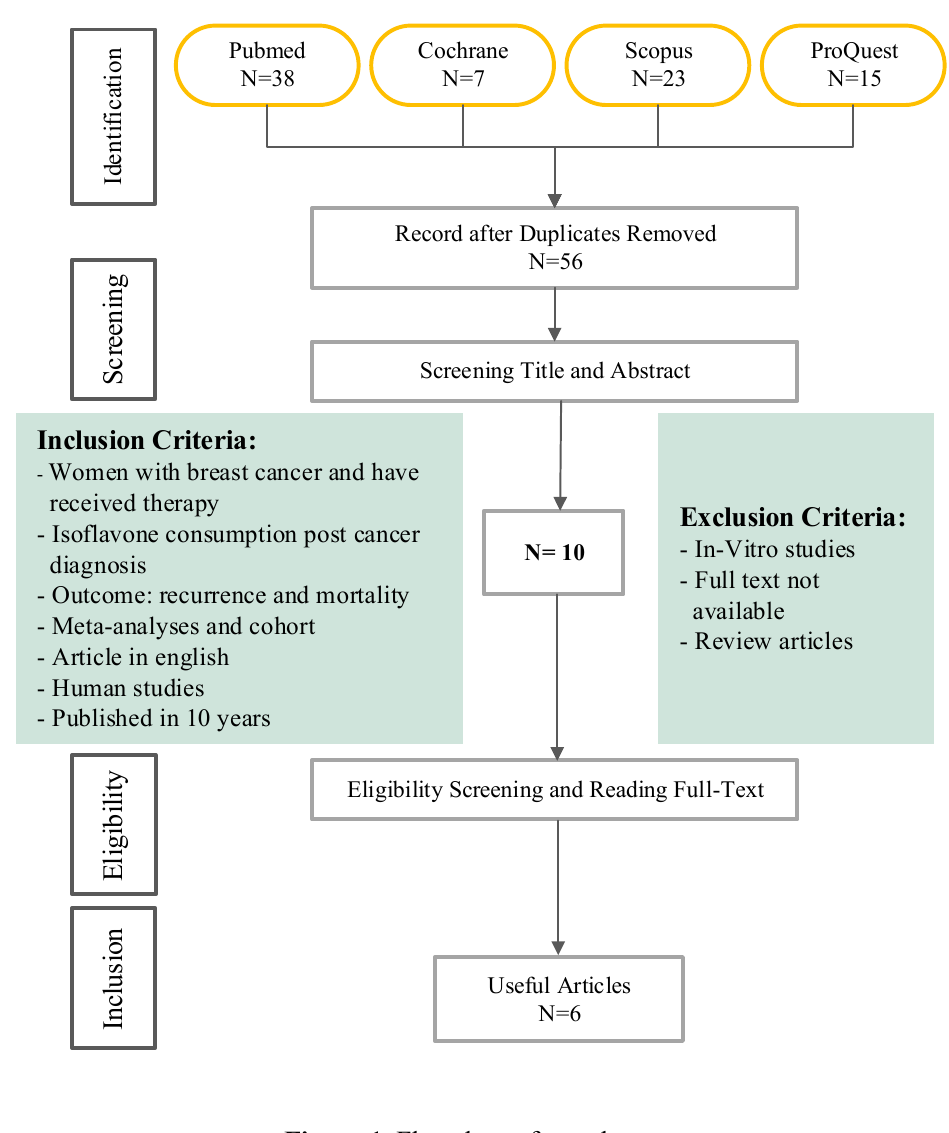
Figure 1. Flowchart of search